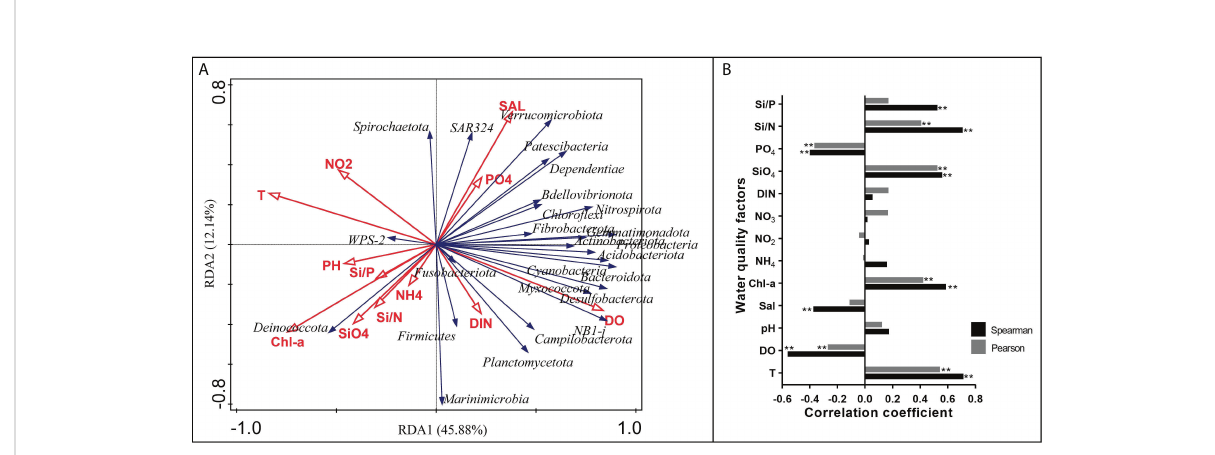
FIGURE 7 Relationships between environmental factors and bacterial community. (A) RDA ordination plot for the fi rst two principal dimensions of the relationships between the phylum taxa abundance and environmental factors in shell fi sh farming areas. (B) The correlation between Vibrio abundance and environmental factors using Spearman ’ s correlation analysis and Pearson ’ s correlation analysis. “ ** ” represent an extremely signi fi cant difference ( P